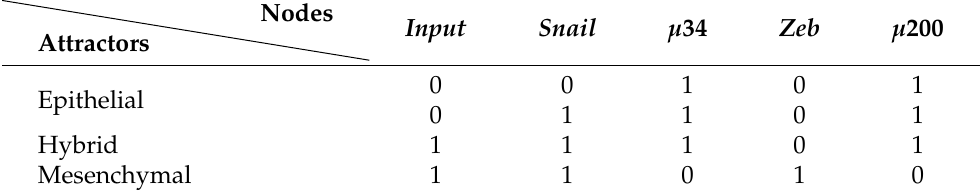
Table 5. Attractors of the network of Equation (18). Every row represents a state of an attractor. In the cyclic attractors (epithelial), states are ordered from top to